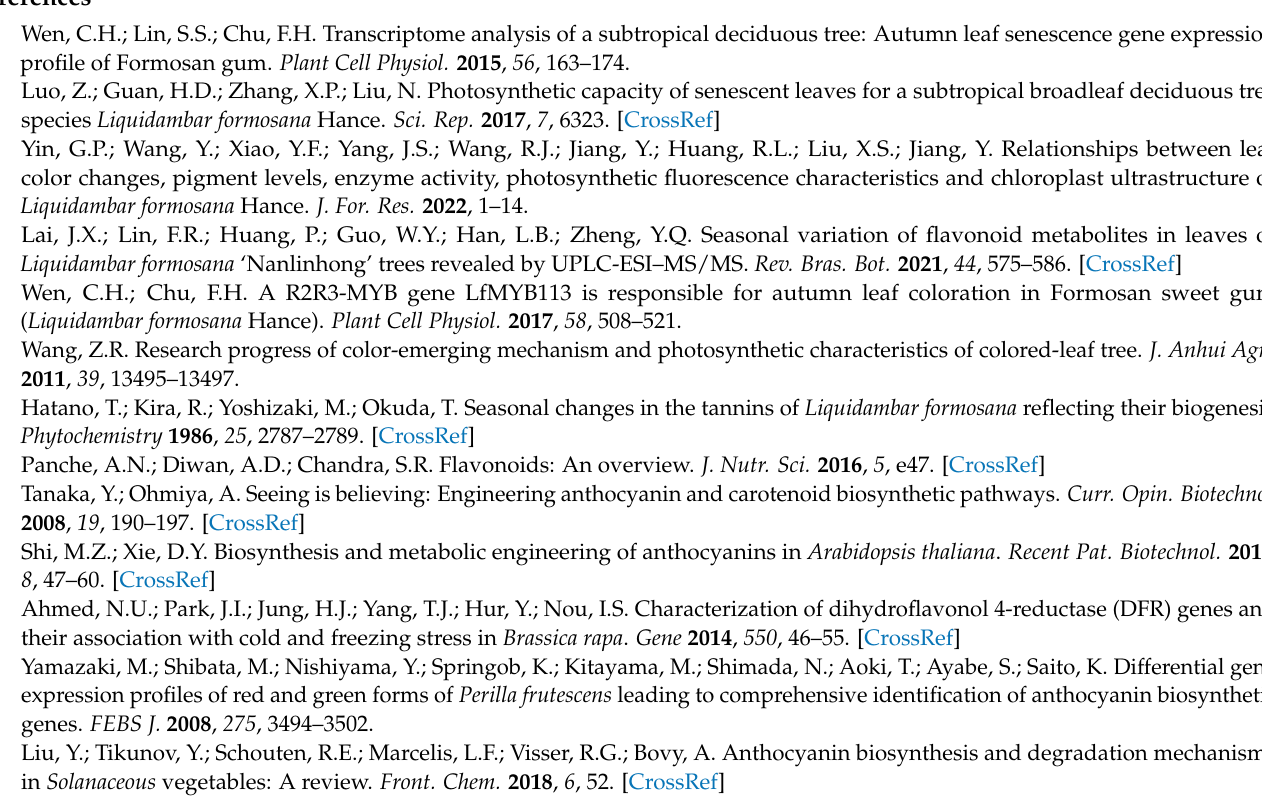
Figure S2: COG classification statistics; Table S1: Transcriptome sequencing data; Table S2: Statistical analysis of TPM value; Table S3: Primers used in